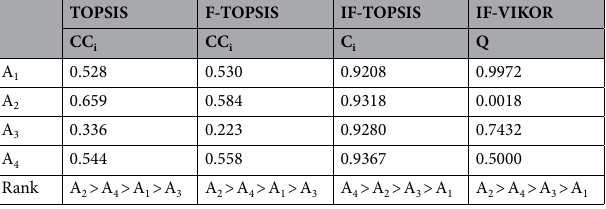
Table 7. The sensitivity analysis performed by TOPSIS, fuzzy TOPSIS, IF TOPSIS and, IF